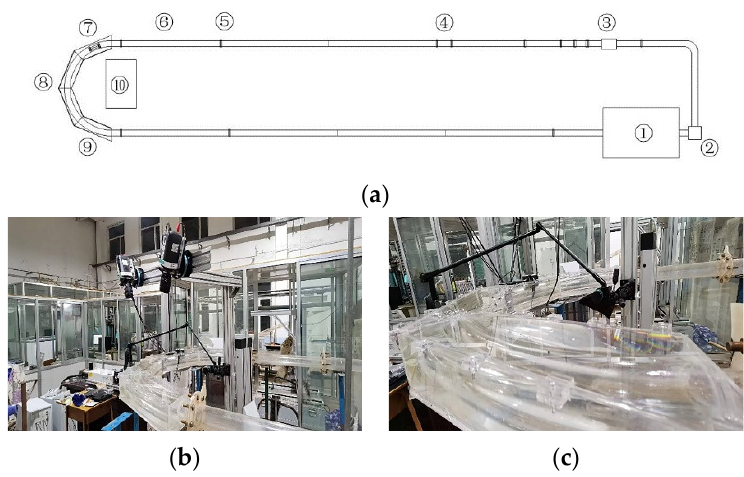
Figure 2. Experiment system: ( a ) schematic diagram, ① -tank, ② -centrifugal pump, ③ -flowmeter, ④ -launch device, ⑤ -flange, ⑥ -straight pipeline, ⑦ -wheeled capsule, ⑧ -bend pipeline, ⑨ -rectangular tank, ⑩ -PIV; ( b ) PIV measuring; ( c ) bend pipe. Table 1. Experimental settings for PIV measurements.